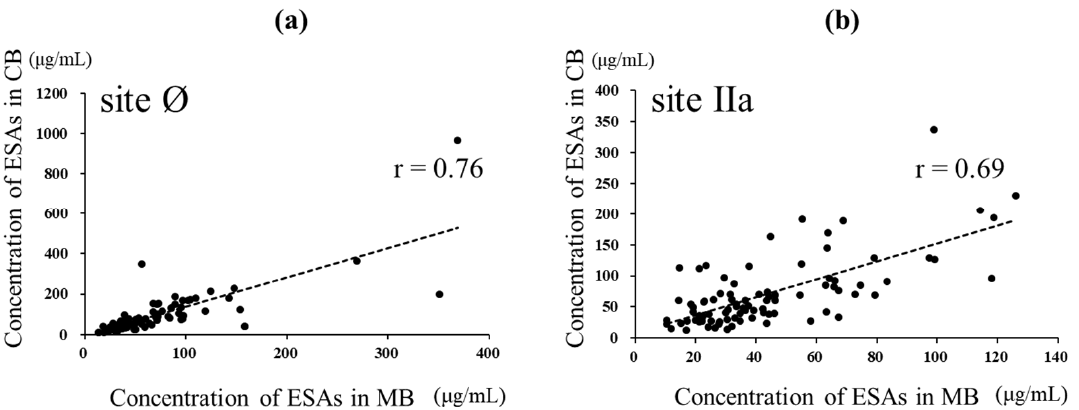
Figure 4. Relationship between ESAs specific to sites Ø and IIa in maternal and cord blood. In total, 87 MB and CB paired samples were evaluated for ESAs. ( a ) Relationship between the ESA level specific to site Ø in MB and CB. The broken line represents linear regression (r = 0.76, p < 0.001)). ( b ) Relationship between the level of ESA specific to site IIa in MB and CB. The broken line represents linear regression (r = 0.69, p < 0.001). Pearson’s product-moment correlation coefficient.